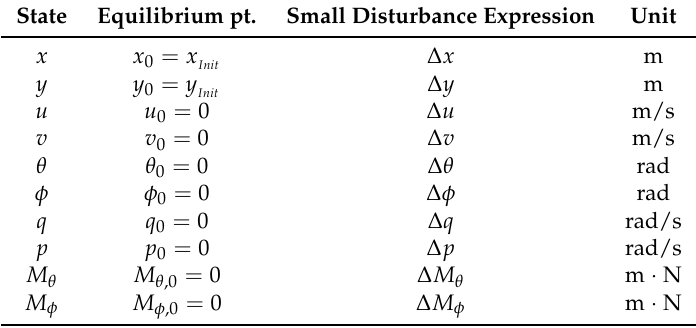
Table 1. Equilibrium pt. and small disturbance expression of each state and controls in horizontal motion. State Equilibrium pt. Small Disturbance Expression Unit